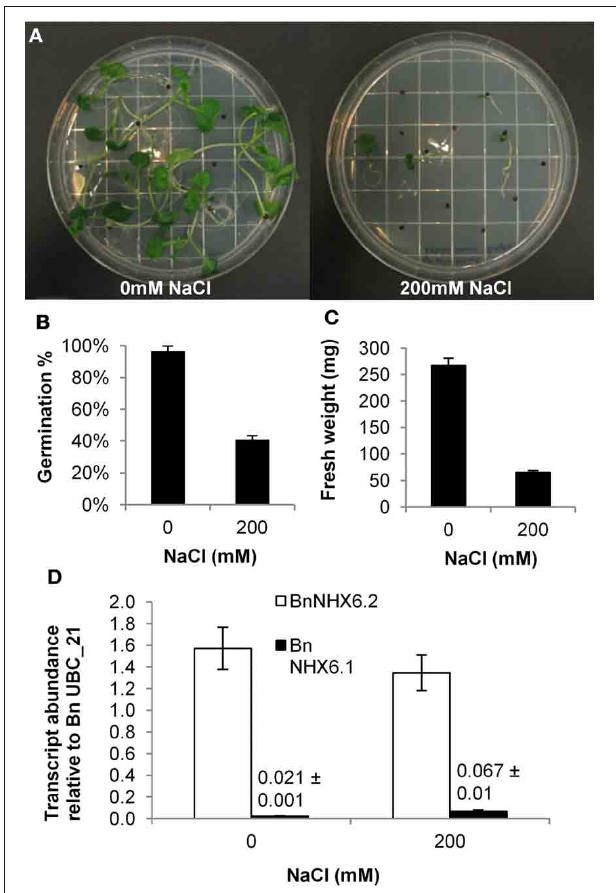
FIGURE 7 | Differential expression of BnNHX6.1 and BnNHX6.2 in B. napus seedlings in response to NaCl. B. napus (cv Westar) seeds were sown on ½ strength MS media with or without 200mM NaCl (A) and the germination percentage (B) and fresh weight per seedling (C) were compared between the two treatments. RNA was extracted from seedlings and the transcript abundance of BnNHX6.1 and BnNHX6.2 was assayed relative to the BnUBC_21 reference gene (D) . Data are the means of three biological replicates ( ±